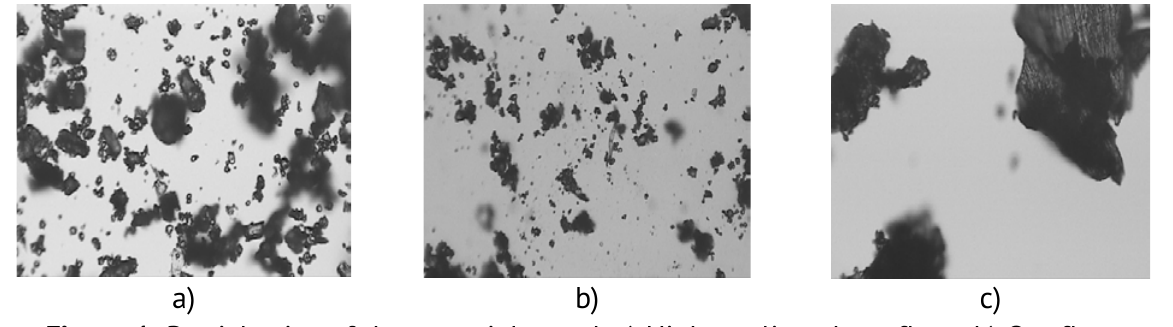
Figure 1. Particle size of the materials used: a) High quality wheat flour; b) Oat flour; c) Whole wheat